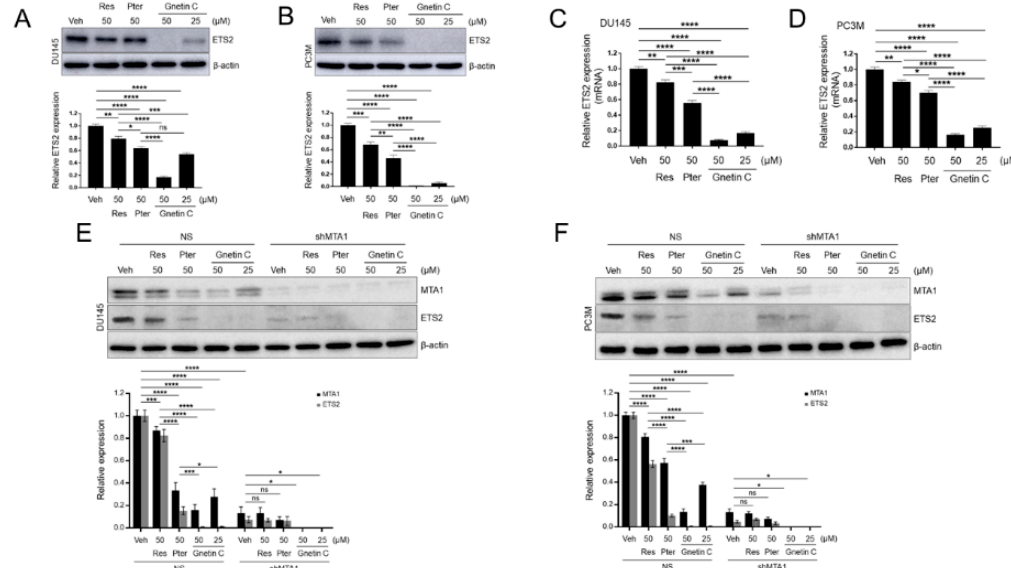
Figure 7. Gnetin C is more potent than resveratrol and pterostilbene in inhibiting MTA1-dependent ETS2 in PCa cells. ( A , B ) Comparison of ETS2 inhibition by Res (50 μ M), Pter (50 μ M), and Gnetin C (25 μ M, 50 μ M) in DU145 and PC3M cells, respectively. Bottom , quantitation of ETS2 levels under Res, Pter, and Gnetin C treatment. ( C , D ) ETS2 mRNA levels were analyzed by qRT-PCR after treatment with Res (50 μ M), Pter (50 μ M), and Gnetin C (25, 50 μ M) in DU145 and PC3M cells, respectively. Data represent the mean ± SEM of three independent experiments. * p < 0.05; ** p < 0.01; *** p < 0.001; **** p < 0.0001 (one-way ANOVA). ( E, F ) MTA1 and ETS2 protein levels were determined in DU145 and PC3M cells expressing MTA1 (NS) and MTA1 knockdowns (shMTA1) treated with Res (50 μ M), Pter (50 μ M), and Gnetin C (25,50 μ M). Bottom , quantifications of MTA1 and ETS2 levels under Res, Pter, and Gnetin C treatment in DU145 and PC3M cells. Data represent the mean ± SEM of three independent experiments. * p < 0.05; ** p < 0.01; *** p < 0.001; **** p < 0.0001 (two-way ANOVA).